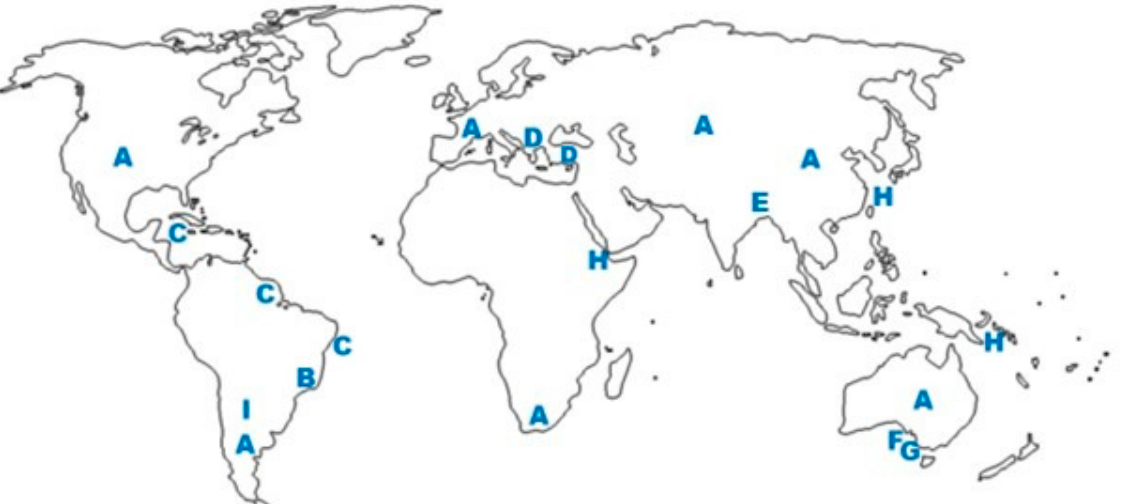
Figure 2. Examples of propolis types with known botanical origin and corresponding world loca- tion. A : temperate propolis, derived from Populus species; B : green propolis from southeast Brazil, derived from Baccharis dracunculifolia ; C : red propolis from the littoral of northeast Brazil, derived from Dalbergia ecastaphyllum ; D : Mediterranean propolis, derived from conifers and other plant species; E : Nepalese propolis, derived from Dalbergia sp.; F , G : propolis types from Kangaroo Islands, derived from Leptosperma sp. and Acacia paradoxa [27,31]; H : propolis Okinawa, Taiwan, Kenya [32] and Solomon Islands [33], derived from Macaranga spp.; I : Argentinean propolis, derived from Zuccagnia punctata .